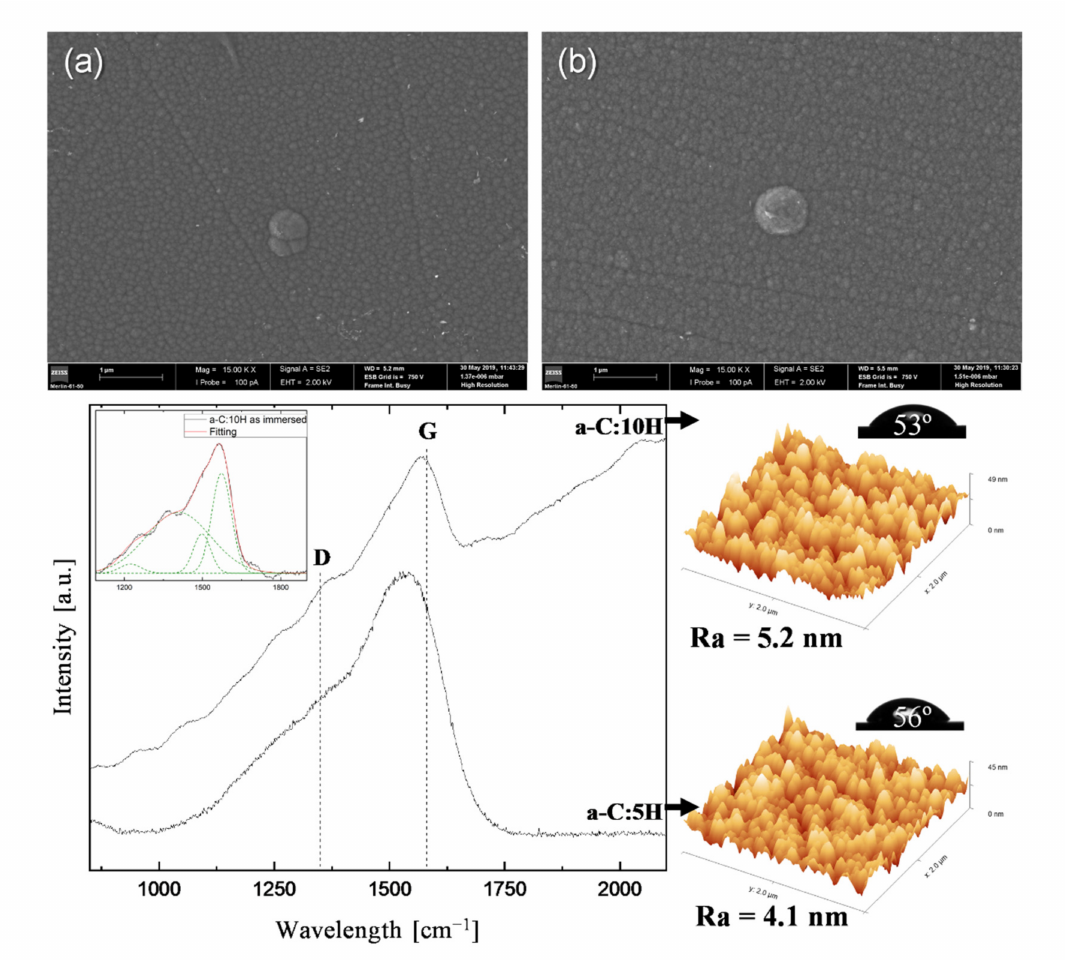
Figure 3. Surface SEM micrographs of the as-immersed ( a ) a-C:5H and ( b ) a-C:10H coatings, and the corresponding visible Raman spectra (inset: Gaussian fitting procedure for a-C:10H films), AFM surface topography, and drop contact